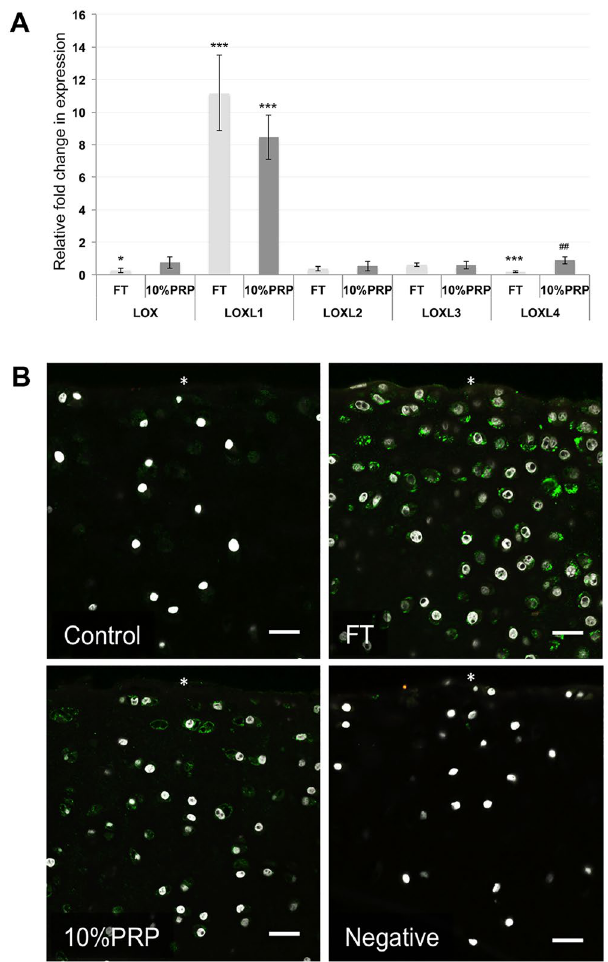
Figure 5. PRP upregulates LOXL1 gene expression and increases antibody labeling in the surface of immature cartilage explants. Graph showing the effect of 10% PRP and growth factors FGF2 and TGF β 1 (FT) treatment on the relative-fold gene expression of all known LOX isoforms compared to untreated explants. ( A ) The y-axis shows the relative fold change in gene expression calibrated to control samples. Significance values signified by * and *** equate to P < 0.05 and 0.001 versus control explants, and ## equates to P < 0.01 between treated groups. Confocal microscopy analysis of LOXL1 immunolabelling (green) and nuclei staining (white) in growth factor and 10% PRP treated cartilage ( B ). White asterisk denotes explant surface. The negative control, goat IgG, shows no positive labelling ( E ). Scale bar equals 20 μ